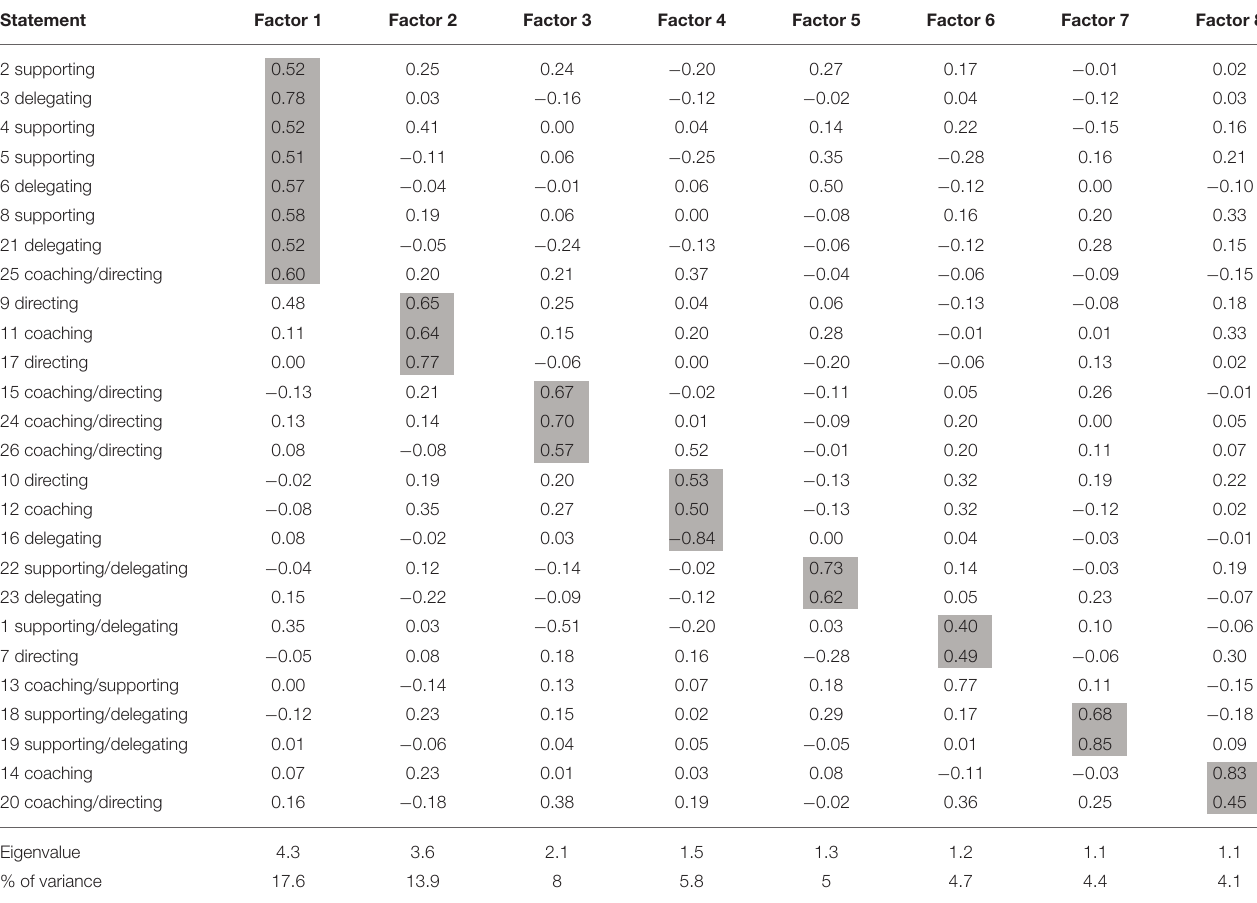
TABLE 5 | Estimation results of factor